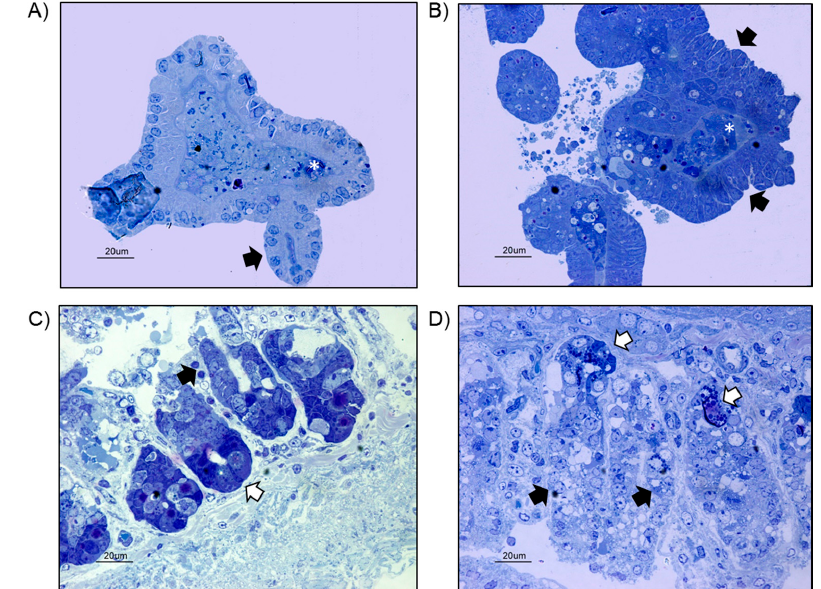
Figure 2. ( A ) Light microscopy analysis of blue toluidine stained WT-organoids showing enterocytes arranged in a round irregular monolayer and delimiting a central lumen in which some necrotic cells were observed (white asterisk). Some buds, mimicking the intestinal crypts, extended from the organoid (black arrow) (bar: 20 μ m). ( B ) Light microscopy analysis of UC-organoids, showing enterocytes arranged in an irregular multilayer structure (black arrows), surrounding a necrotic area (white asterisk) (bar: 20 μ m). ( C ) Small intestine from WT mice, showing intestinal villi in longitudinal section. Enterocytes (black arrow) and Paneth cells (white arrow) were observed (bar: 20 μ m). ( D ) Small intestine from Winnie mice showing intestinal villi in longitudinal section. A less-organized morphology was observed in which enterocytes (black arrow) and Paneth cells (white arrow) were hardly recognizable (bar: 20 µ